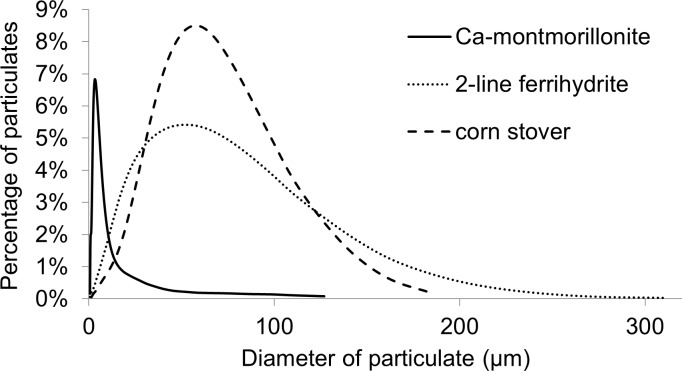
Particulate size distribution.